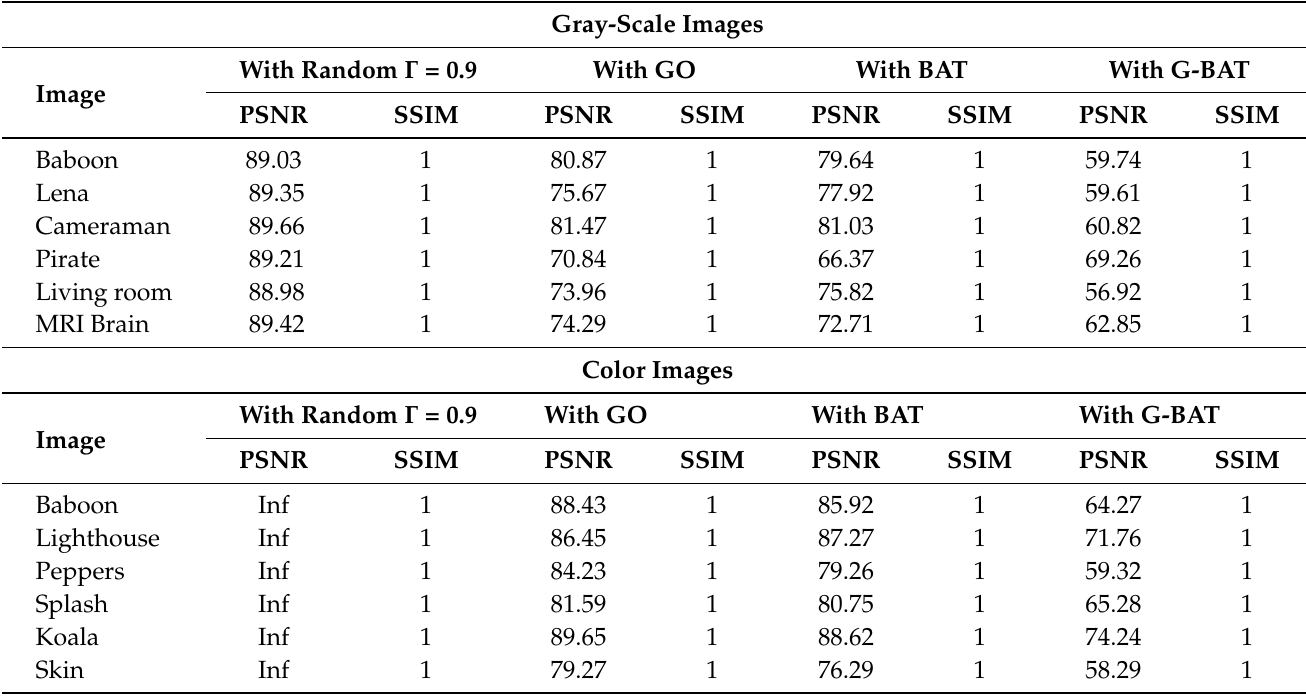
Table 2. PSNR and SSIM for general images (gray-scale and color) with random Γ = 0.9 and optimized Γ using GO, BAT and